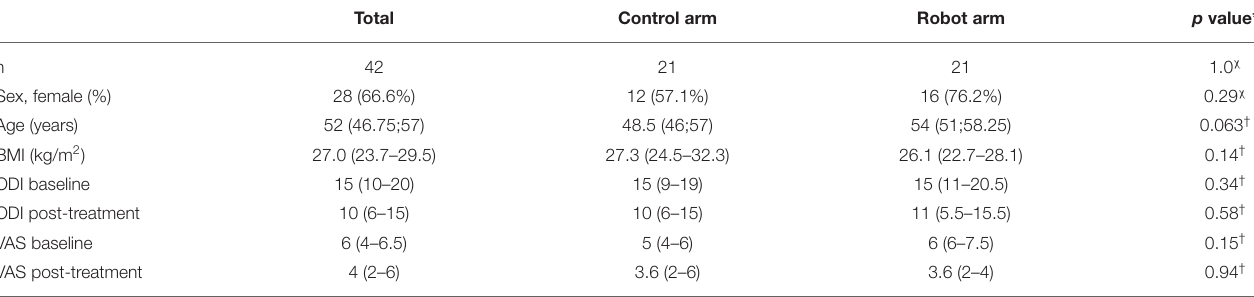
TABLE 1 | Clinical characteristics of patients.